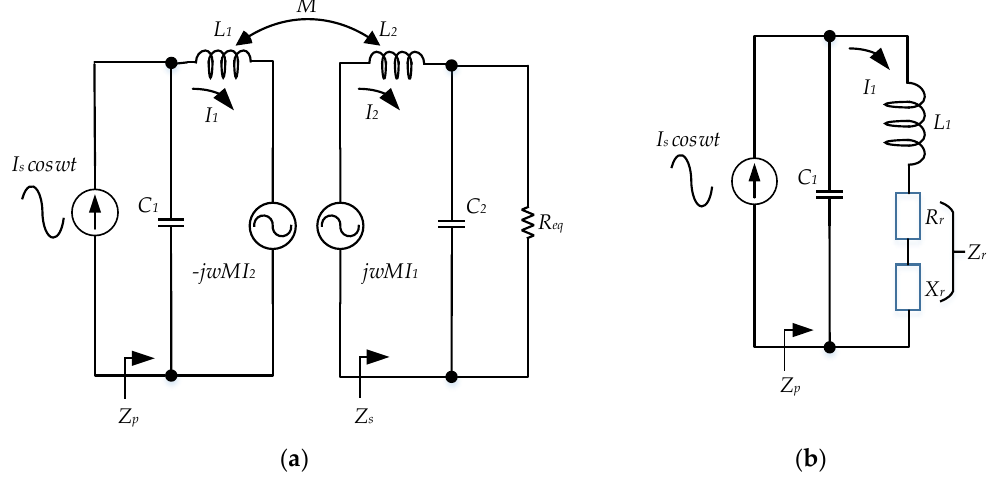
Figure 4. Simplified circuit model: ( a ) with sinusoidal current source and mutual voltage; ( b ) with reflected impedance.